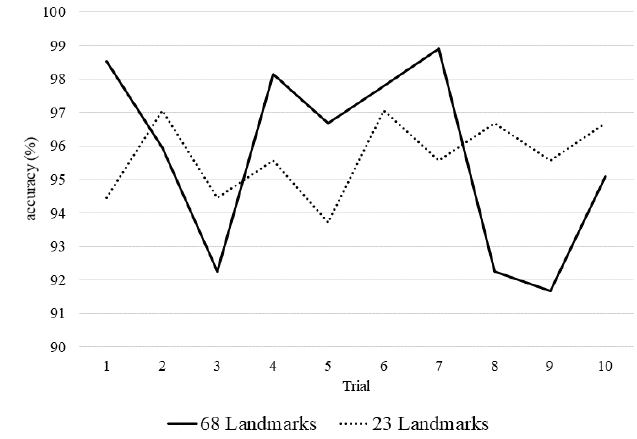
Figure 14. Comparison of accuracy according to the number of landmarks.